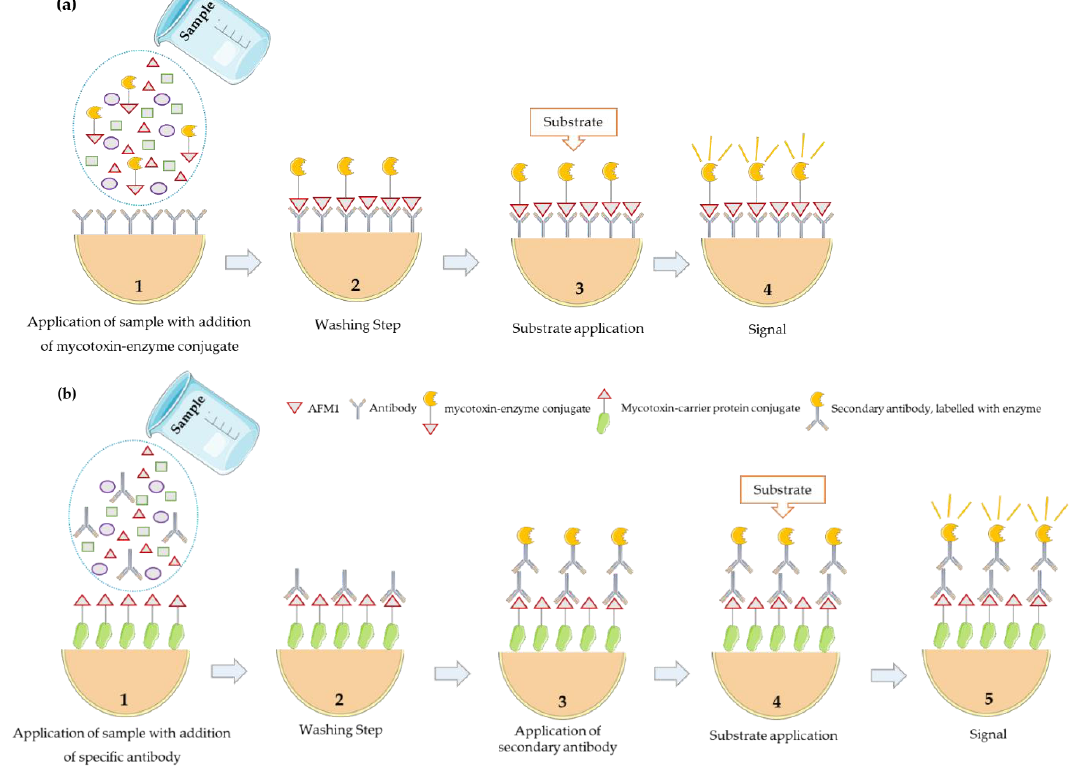
Figure 5. Competitive ELISA principle. ( a ) Direct format and ( b ) indirect format.